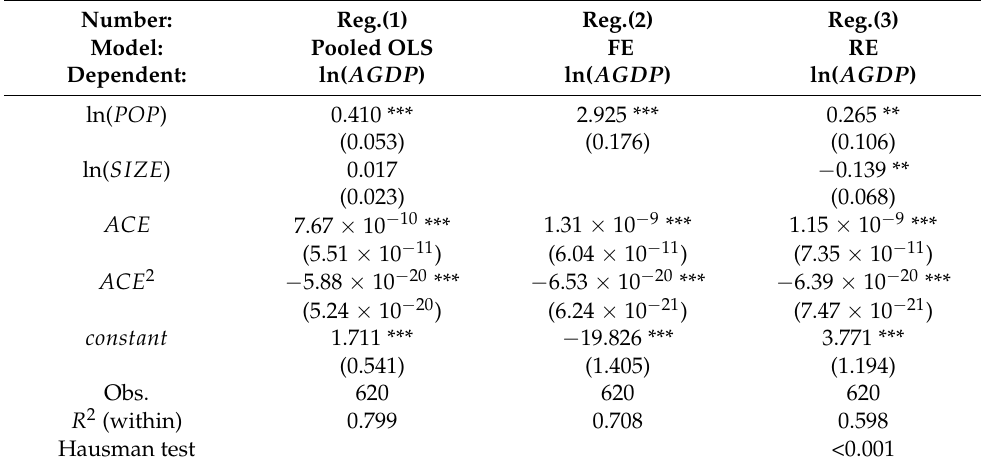
Table 4. Estimated Results of the agricultural GDP.